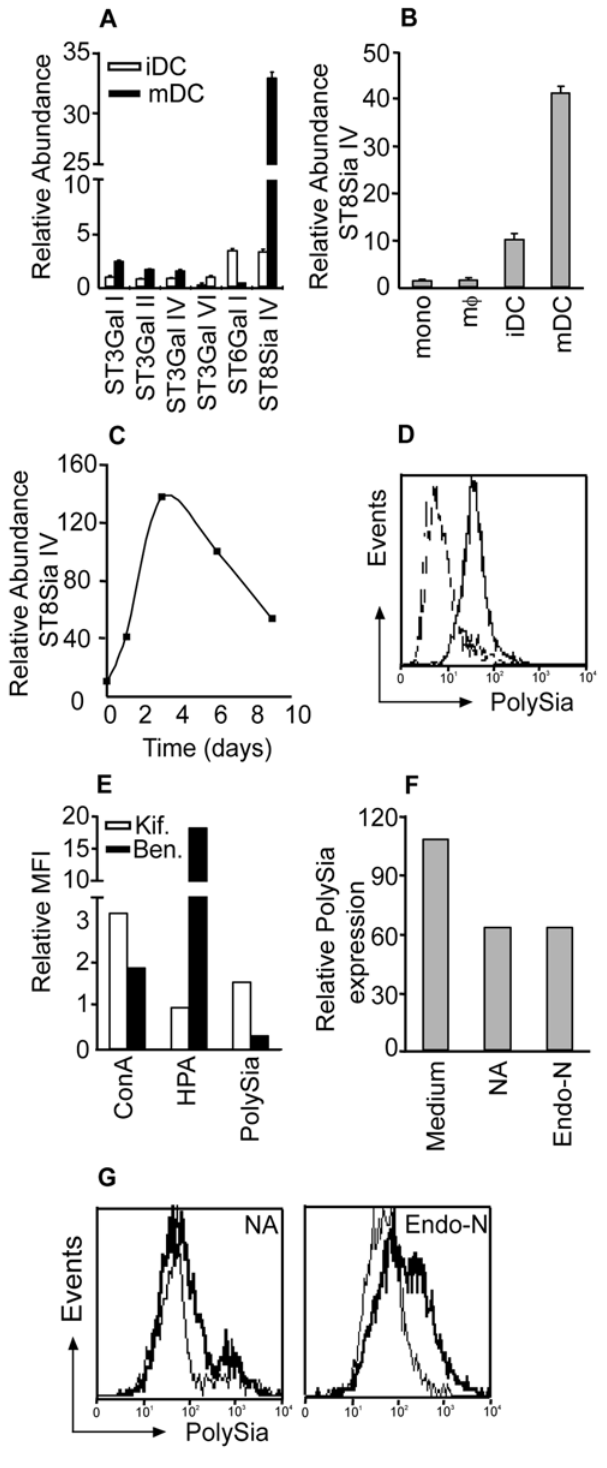
Figure 1. DCs matured for 2 days with LPS express high levels of O-linked polysialic acid. (A) mRNA levels of sialyltransferase genes of iDCs or mDCs triggered for 1 day with LPS were determined by quantitative RT-PCR. Averages of 6 donors are depicted. (B) Expression levels of ST8Sia IV in myeloid cells as measured by quantitative RT-PCR (N=3). (C) Time course of ST8Sia IV expression after LPS triggering, as analyzed by quantitative RT-PCR. One representative donor is shown. (D) Expression levels of polySia by iDCs (dotted line) and DCs matured for 2 days with LPS (bold line) or 1 day with LPS (thin line), as